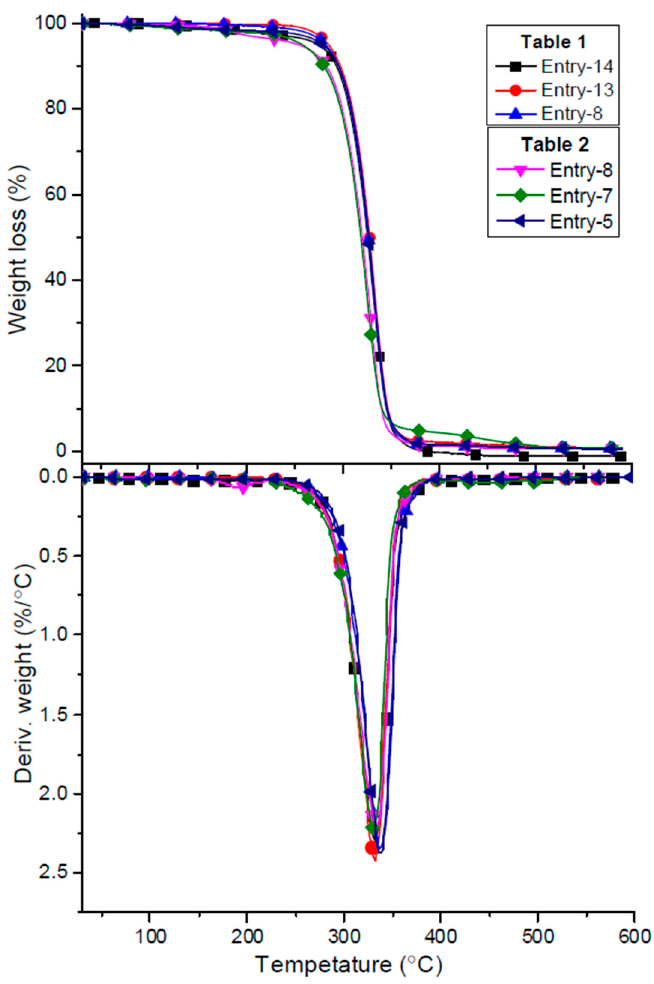
Figure 3. TG and DTG plots of polyesters (Table 1, entry 8, 13, and 14) obtained by using Bu 4 NCl and polyesters (Table 2, entry 5, 7, and 8) obtained by using DMAP as a co-catalyst.